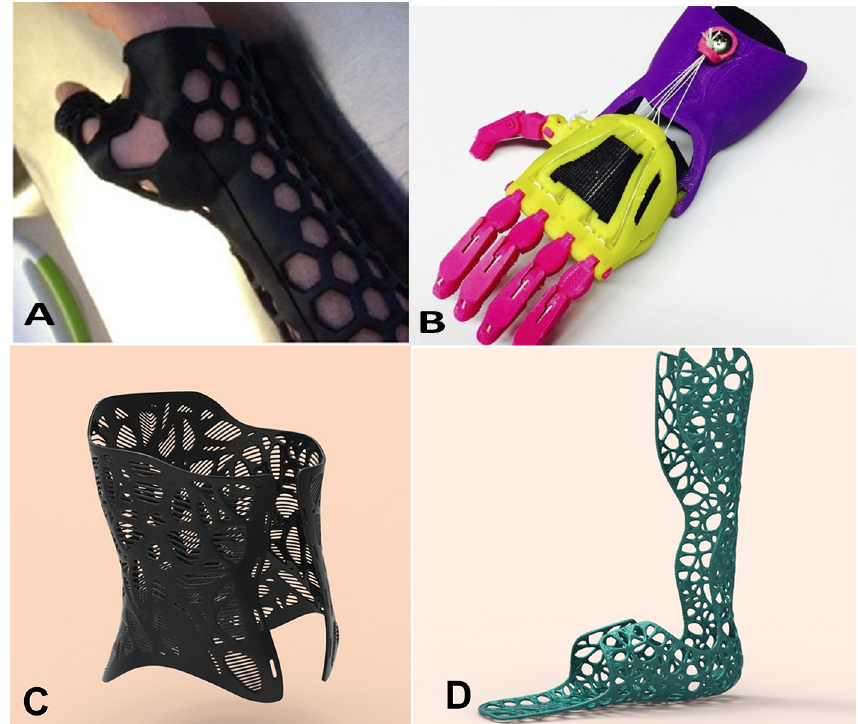
Figure 1. Examples of 3D printed orthotics ( a ) Forearm static fixation (courtesy of Fitzpatrick et al. [21]). ( b ) Cyborg beast hand prosthesis—a low-cost 3D-printed prosthetic hand for children licensed under the CC-BY-NC license (courtesy of Zuniga et al. [19]). ( c ) Spinal brace (courtesy of Andiamo company [22]). ( d ) Ankle-foot orthosis (courtesy of Andiamo company